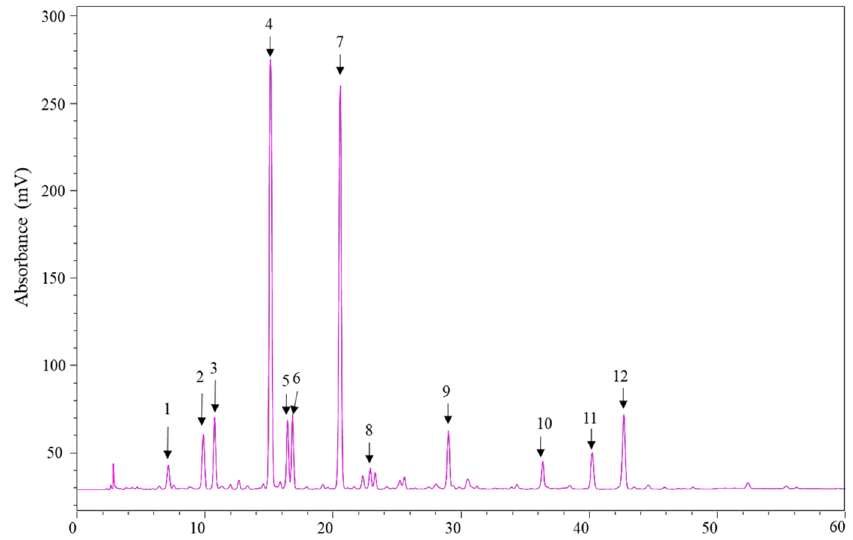
Figure 4. HPLC–PDA chromatogram of identified compounds in enriched PLS extracts monitored at 254 nm. Table 1. Peak assignments in the HPLC–PDA–ESI–MS/MS analysis of enriched PLS extract. Peak